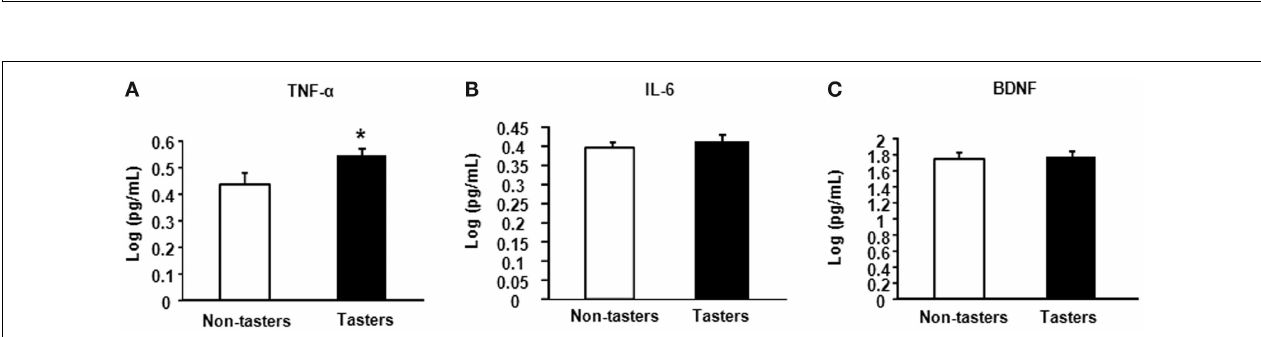
FIGURE 3 | Plasma levels of inflammatory and growth factors .The inflammatory factorsTNF- α (A) , IL-6 (B) , and brain-derived neurotrophic factor BDNF (C) were measured. Results were log-transformed and subjected to a non-paired two-tailed t -test. A value of p < 0.05 was considered statistically